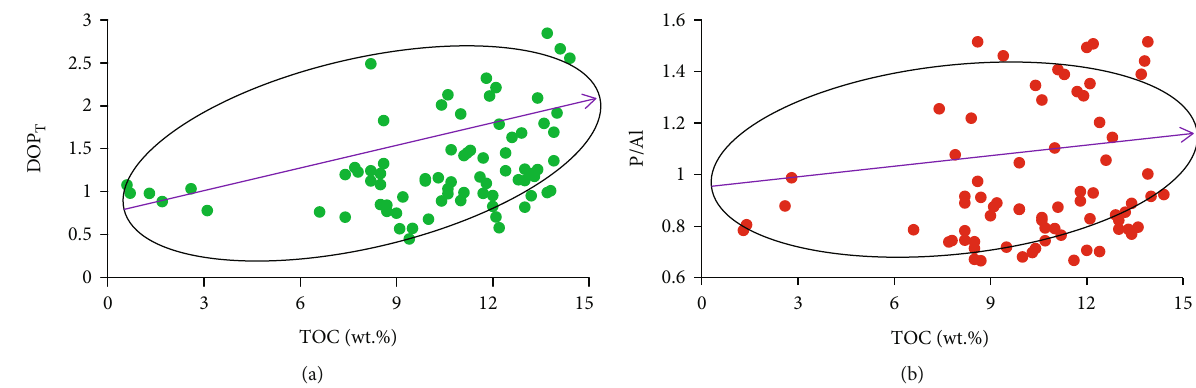
Figure 6: The correlation diagrams of DOP and TOC content (a) and P/Al and TOC content (b) in the redox environment are all positive. T